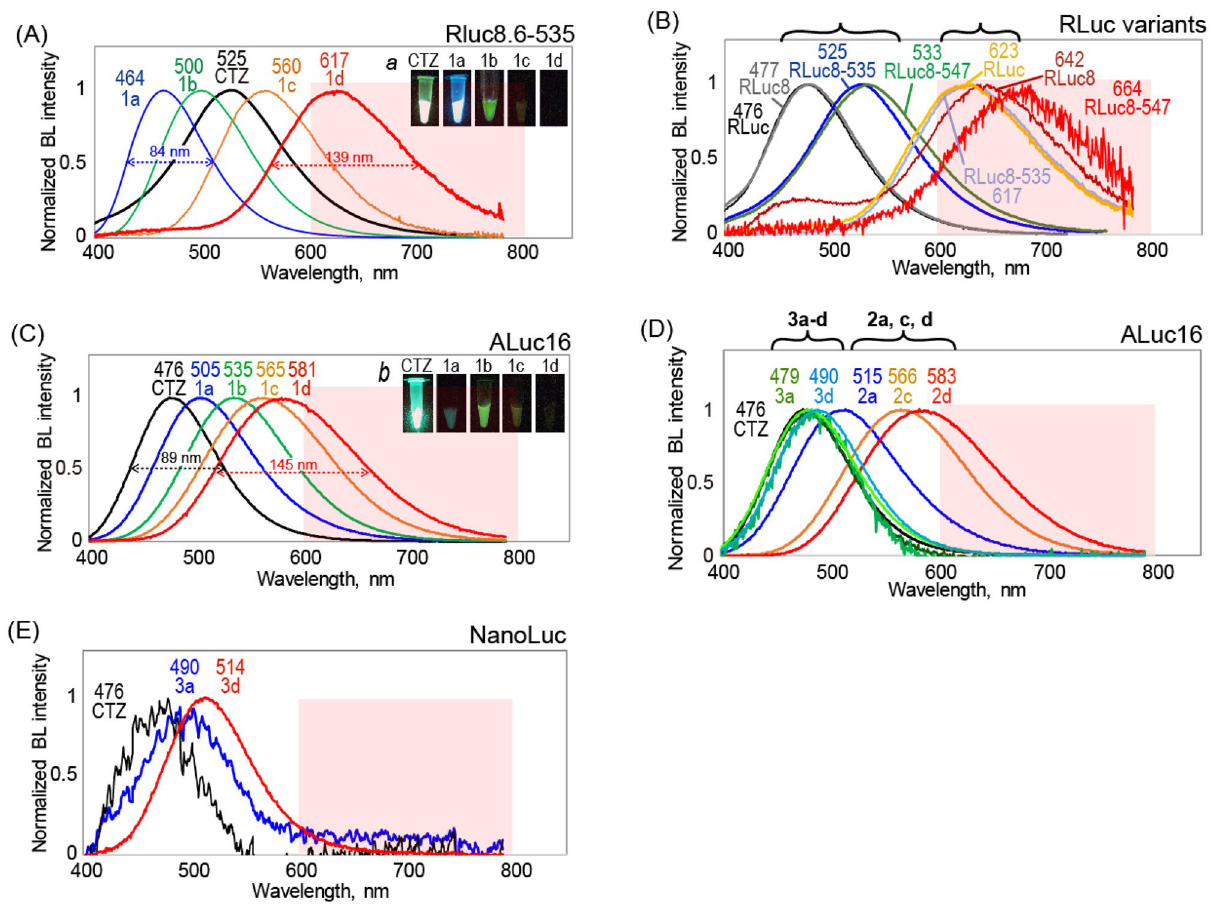
Figure 2. The BL spectra of the CTZ analogues 1a–d , 2a–d , and 3a–d according to marine luciferases. ( A ) The BL spectra of 1-series CTZ analogues with RLuc8.6–535. Inset a shows the optical image of BL. ( B ) The BL spectra of 1d according to various RLuc derivatives. ( C ) The BL spectra of 1-series CTZ analogues with ALuc16. Inset b shows the optical image of BL. ( D ) The BL spectra of 2- and 3-series CTZ analogues with ALuc16. ( E ) The BL spectra of 3a and 3d with NanoLuc. Abbreviations: CTZ, native coelenterazine; FWHM, full width half maximum; BL, Full color spectra of bioluminescence. The BL spectra of the CTZ analogues according to marine lucif- erases were obtained with a highly sensitive spectrometer that simultaneously captures photons with the entire wavelength range in one shot (AB-1850, ATTO) (Fig. 2, Figures S1–S3). The λ BL of RLuc variants and ALuc16 are found to be red-shifted in the descending order of 1a , 1b , 1c , and 1d (Fig. 2A,C). The similar tendency is observed with 2-series CTZ analogues. Interestingly, the full width half maximum (FWHM) is broadened in the same order (Table 1): i.e., 89 nm for nCTZ; 113 nm for 1b ; 145 nm for 1d . The results indicate that the expansion of the π conjugation by increase of the number of double bonds at the C6 position of the CTZ skeleton is the critical determinant for the red- shifts of the BL spectra with marine luciferases. Thus, 1d and 2d exert the most red-shifted BL spectra in the groups. Figure 2B highlights the red-shifted spectra of RLuc variants with 1d, compared to CTZ. We found that all the λ BL values of the RLuc variants with 1d exceed 600 nm. The λ BL values were found at 642, 617, and 664 with RLuc8, RLuc8.6–535, and RLuc8.6-547, respectively (Figs. 2, S1–S3). The most dramatic red-shifts were observed with RLuc8, whose λ BL value shifted from 477 to 642 nm (165 nm gap) through simply replacing CTZ with 1d . Likewise, the λ BL value of ALuc16 was observed from 476 to 581 nm according to the substrates, whose gap was found to be ca. 105 nm between CTZ and 1d . The overall results may be summarized as: (i) the BL colors of marine luciferases are freely tunable from blue to far red (all the visible region) simply replacing the CTZ analogues; and (ii) the extended π conjugation is the principle ingredient for the red-shifted λ BL values with marine luciferases. The notable structural variance between the 1- and 2-series CTZ analogues is whether a hydroxy (OH) group is possessed in the benzyl moiety at the C2 position, and whether the substituent at the C8 position is a benzyl or a phenyl group. Although this is a small structural variance, the 2-series analogues only showed negligible luminesce with all the RLuc deriva- tives. In contrast, the same 2-series analogues significantly emit BL with ALuc16 and preserved the red-shifted tendency according to the extended π conjugation (Fig. 2D).